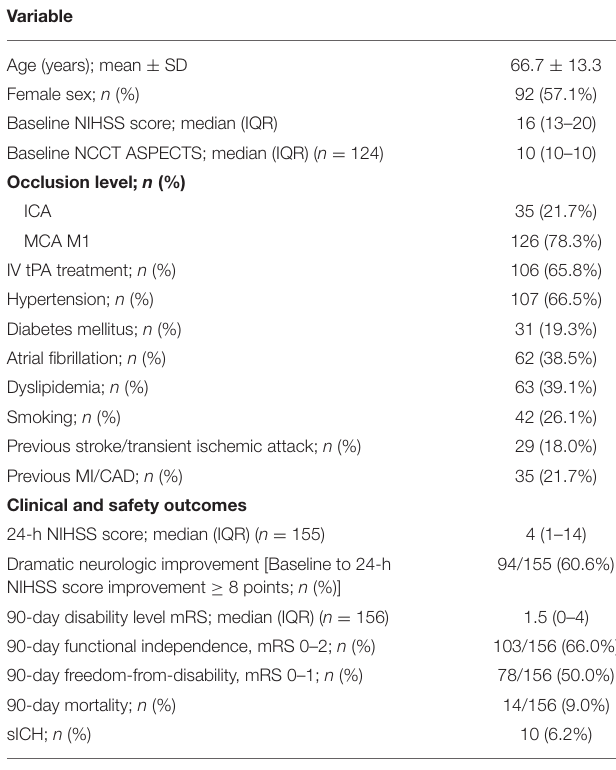
TABLE 1 | Baseline characteristics of study population ( n =